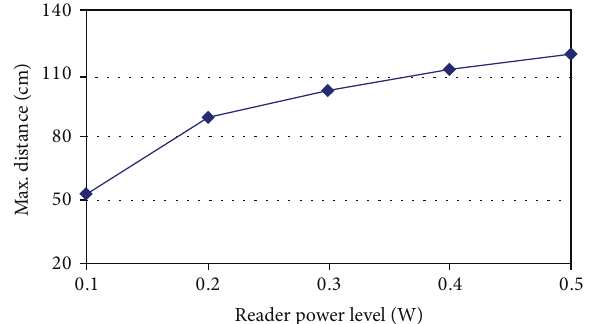
F 13: Max. distance of tag detection versus radiated power.